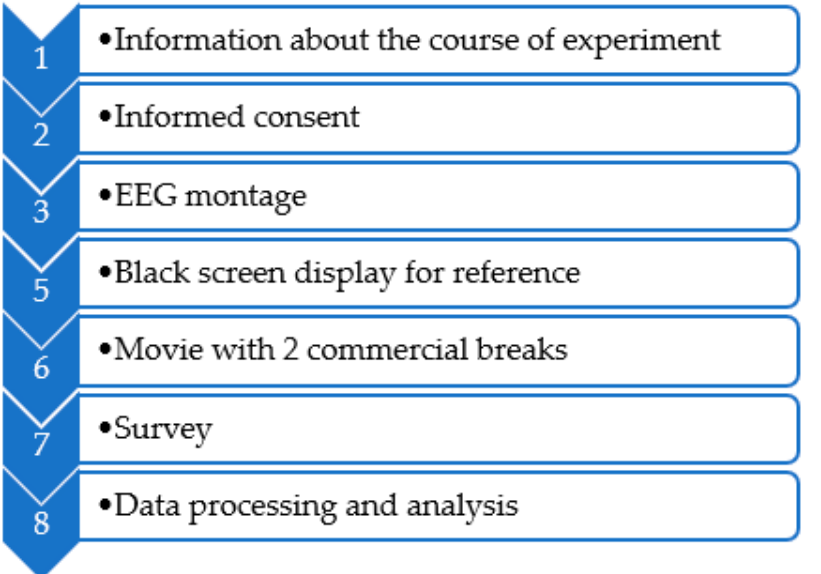
Figure 3. Experimental procedure.